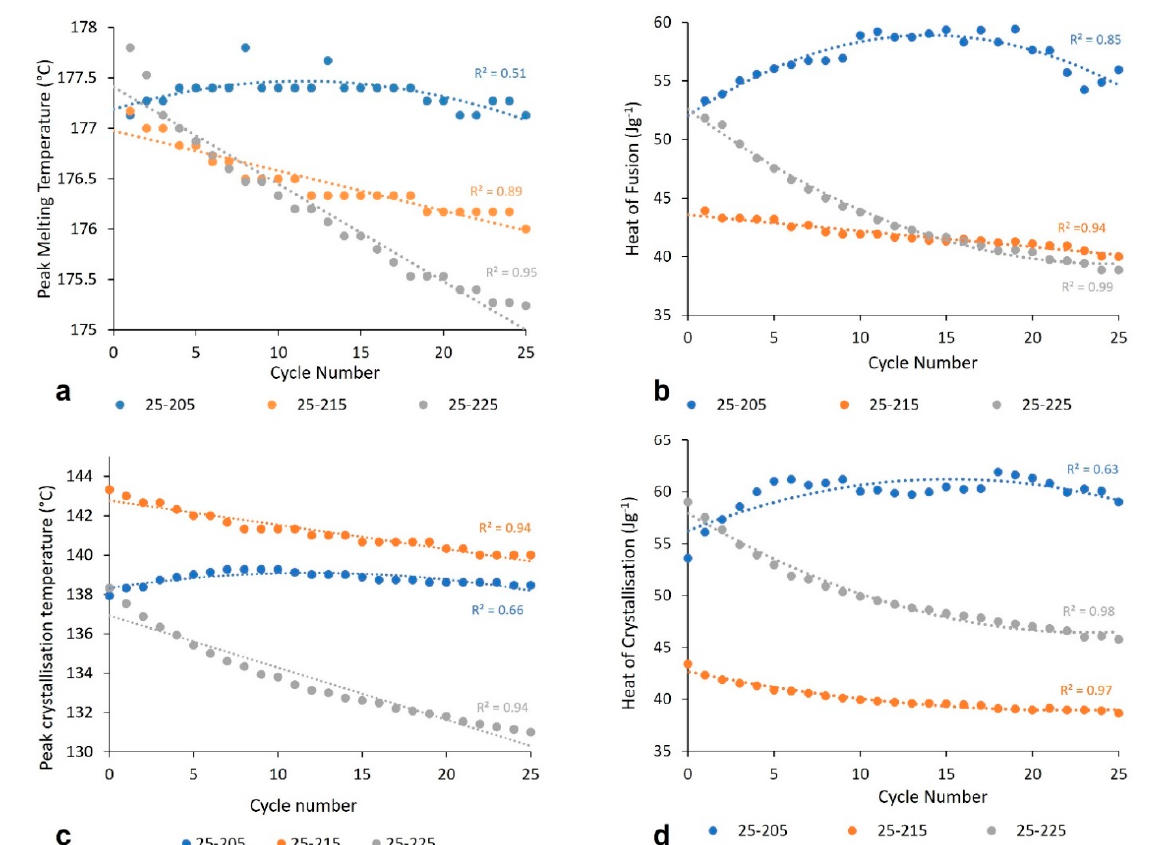
Figure 3. The change in ( a ) peak T m , ( b ) heat of fusion, ( c ) peak T c , and ( d ) heat of crystallisation with increased thermal cycling, with varied upper temperature limits.